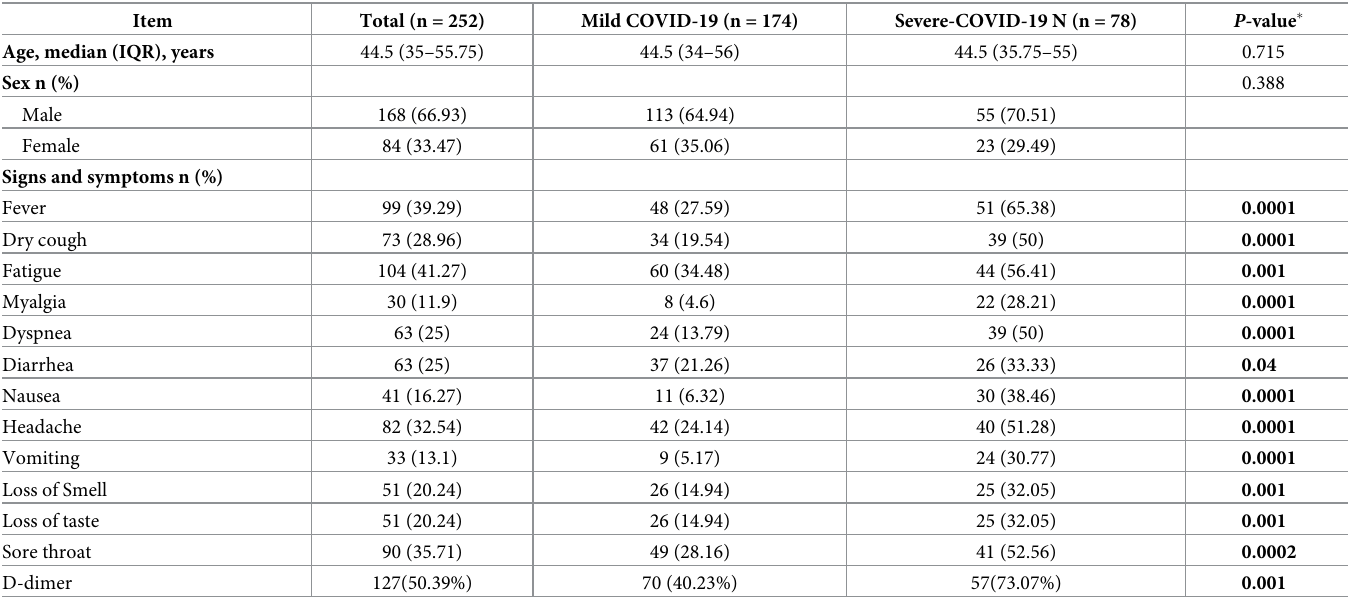
Table 1. Baseline characteristics of patients included in the study.